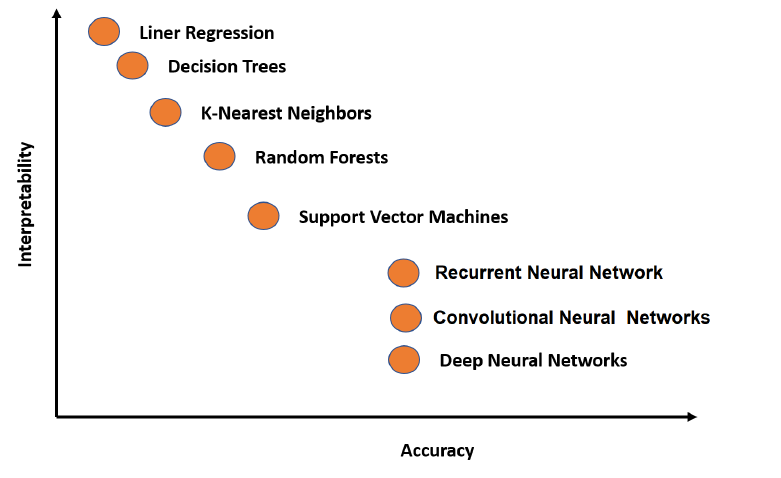
Figure 23. The model interpretability comparison between traditional and deep learning